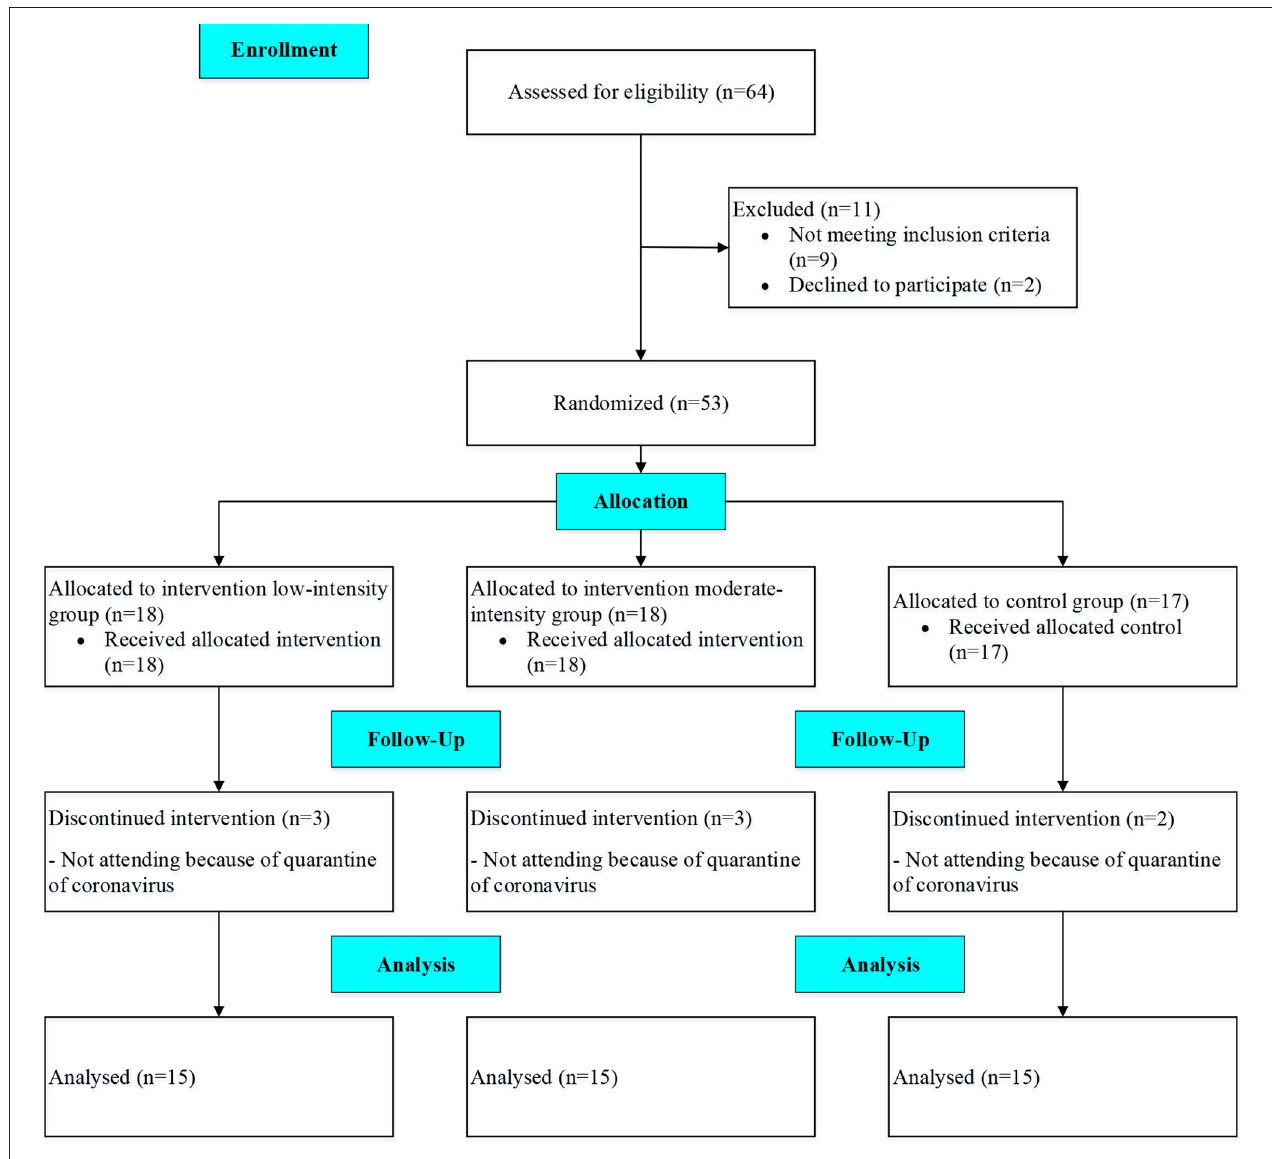
FIGURE 1 | Flow of the